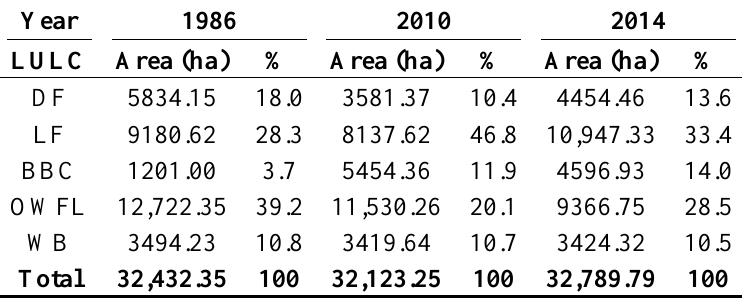
Table 2. Composite table of area statistics in Hectares.